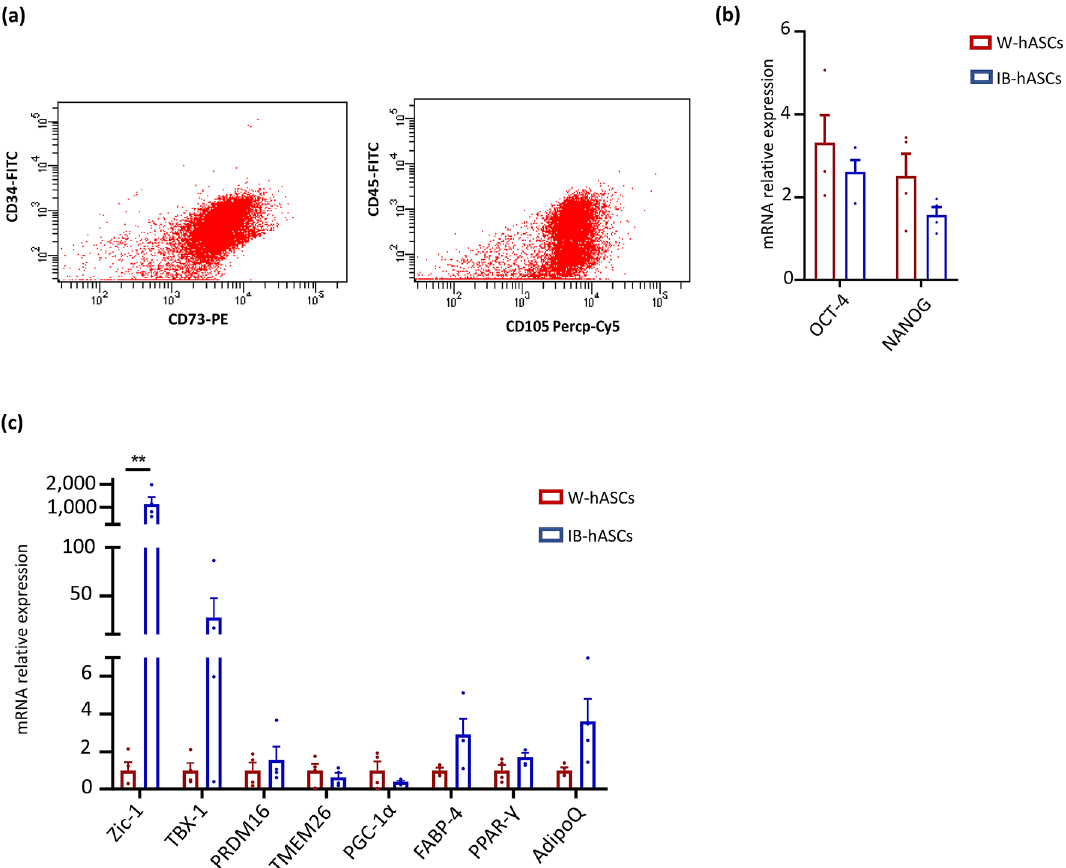
Figure 1. Characterization of stem cells isolated from adipose tissue surrounding a pheochromocytoma. ( a ) Representative flow cytometry analysis confirming that induced brown (IB)-hASCs are positive for the mesenchymal stem cell markers CD73 and CD105. ( b ) Expression of stem cell markers OCT-4 and NANOG in IB-hASCs and in W-hASCs isolated from vWAT. ( c ) Expression of brown-brite and adipocyte markers in IB-hASCs and in W-hASCs from vWAT. n = 4 per group (independent donors). Data are shown as mean ± s.e.m. ** P < 0.01 (unpaired